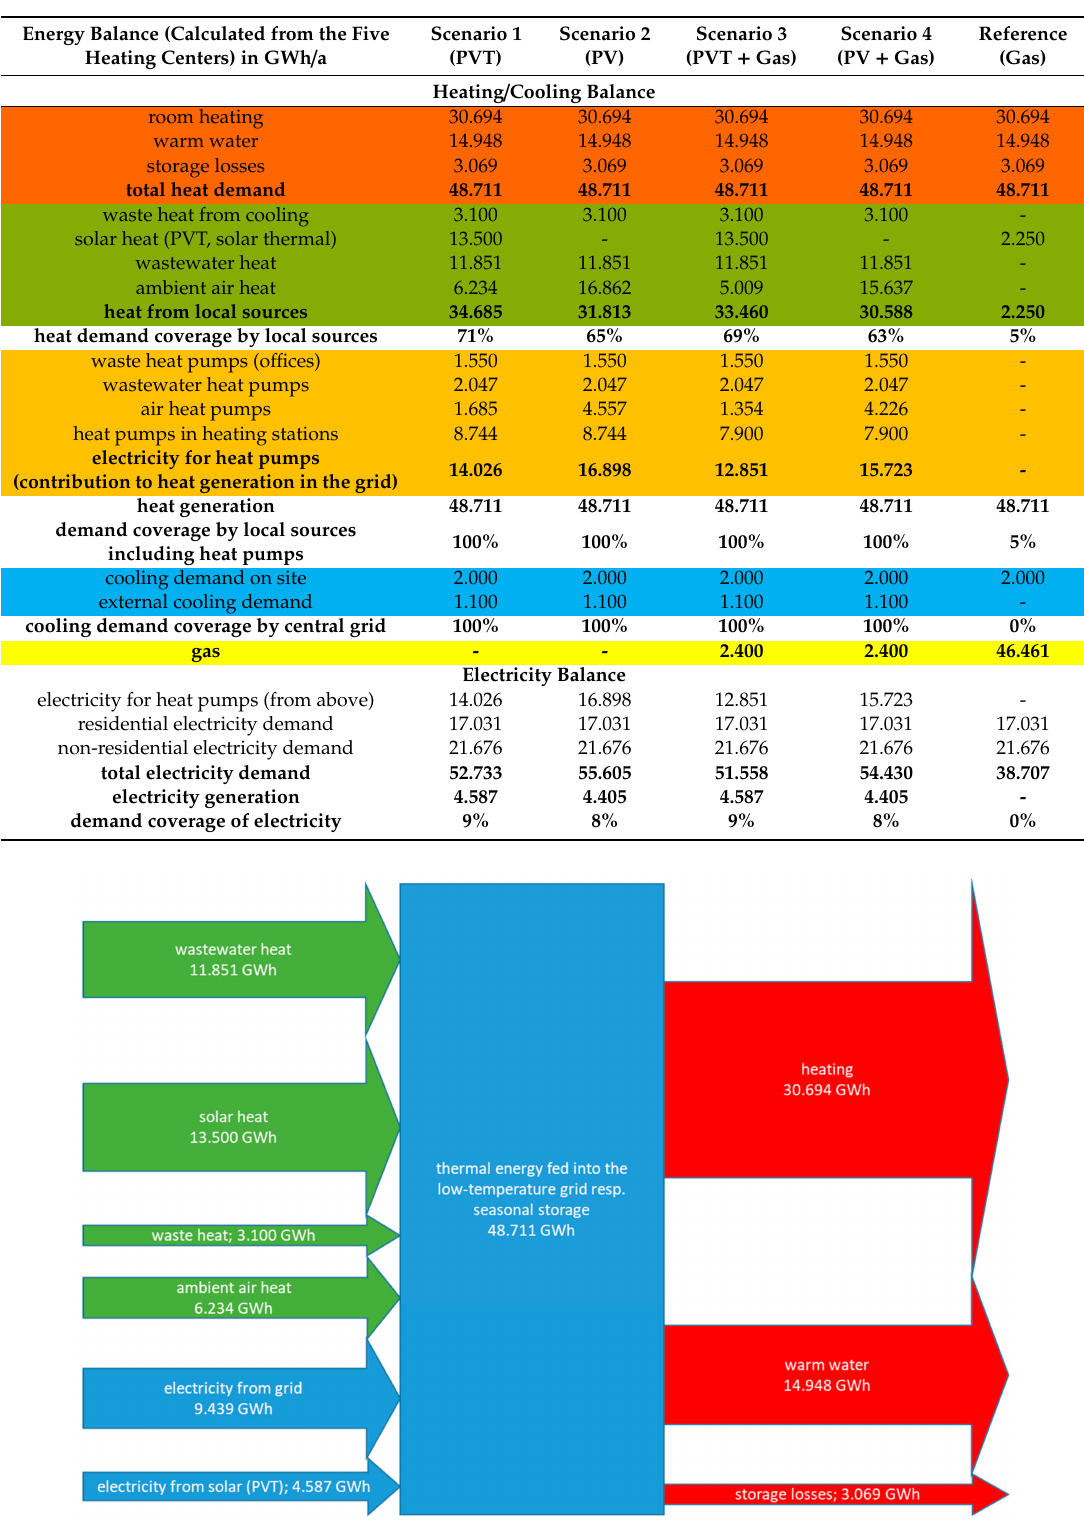
Table 9. Energy balance for the investigated scenarios: Red: Energy consumption; green: Energy provision by source; blue: Cooling demand; orange: Needed electricity for heat pumps; yellow: Natural gas consumption.